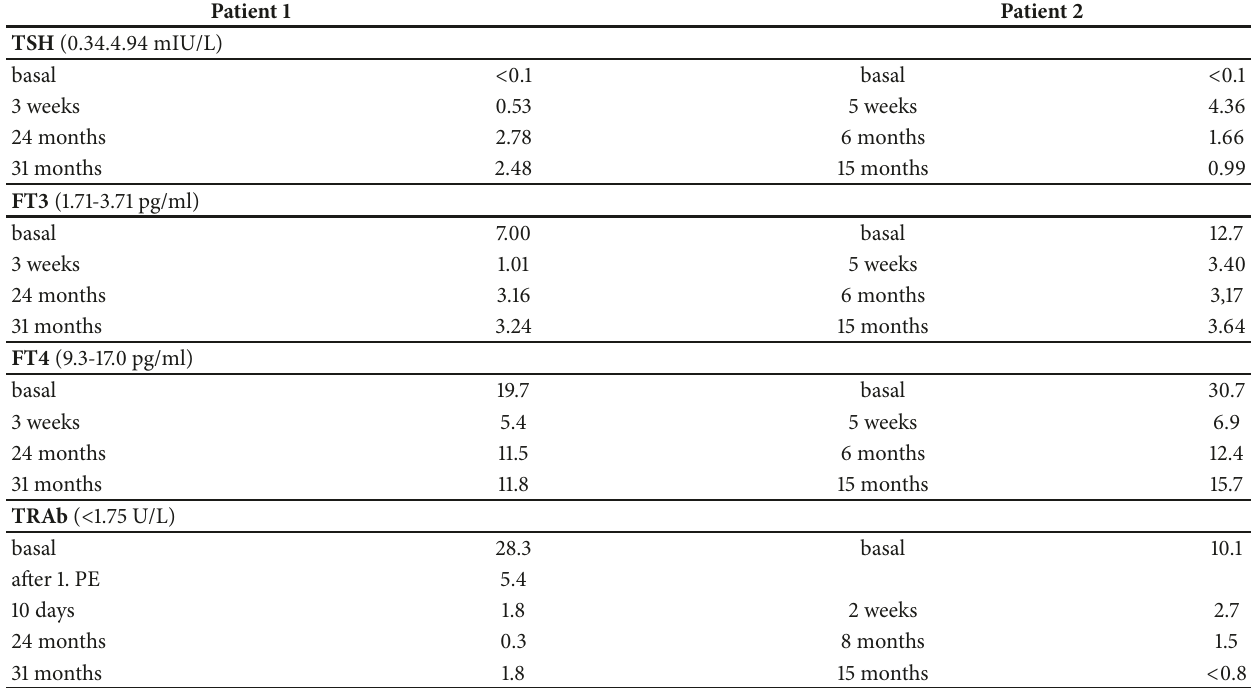
Table 1: Laboratory results of Patients 1 and 2 at time of TTP diagnosis and over the course after TTP